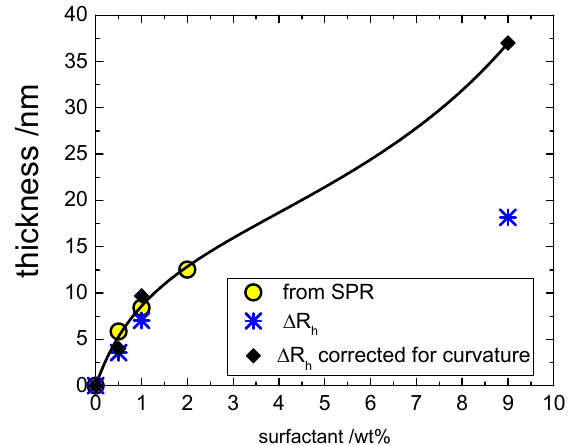
Figure 7. Comparison of the deposited layer of surfactant on the flat and colloidal BSA-coated SiO 2 surfaces where the yellow circles are the values of “wet” thickness obtained by SPR on a flat surface, the asterisks are the hydrodynamic thickness obtained by DLS on a colloidal surface, the black diamonds are the hydrodynamic thickness values corrected for the curvature, and the black line is the fitting of the data using a BET isotherm (Equation (9)); best-fit values are q 1 = 17 ± 3 nm, K L = 0.8 ± 0.3, and K ml = 0.062 ± 0.01 (these constants have dimensions of reciprocal concentration in wt%).